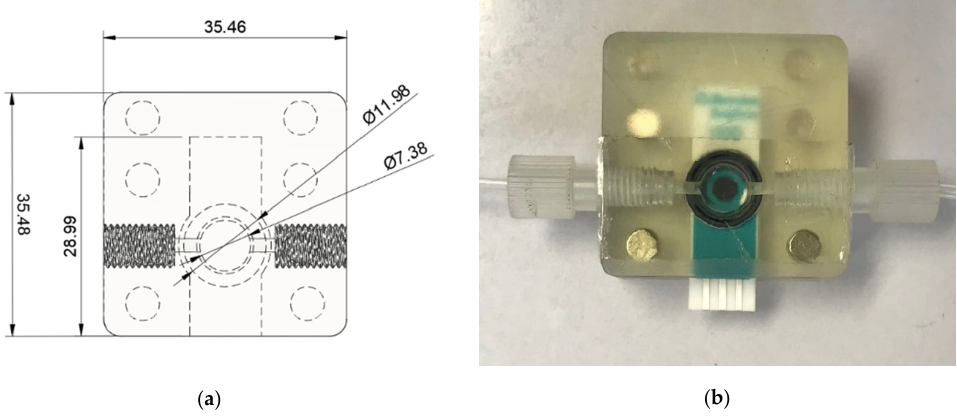
Figure 8. Detection unit: ( a ) CAD file of 3D ‐ printed flow cell; ( b ) photograph of the flow cell accommodating a SPE.